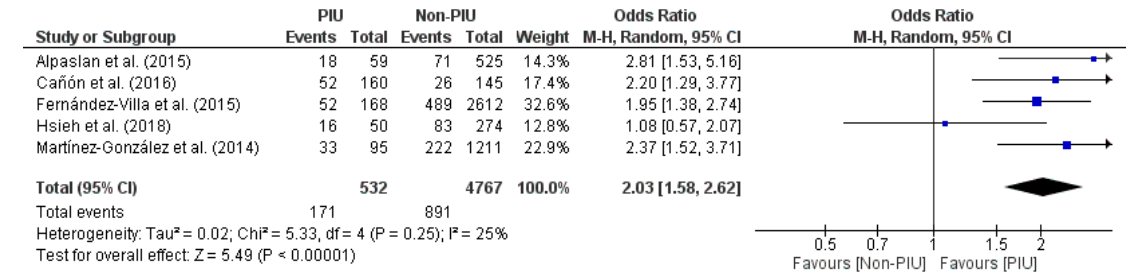
Figure 4. Forest plot of meta-analysis with dichotomous data.